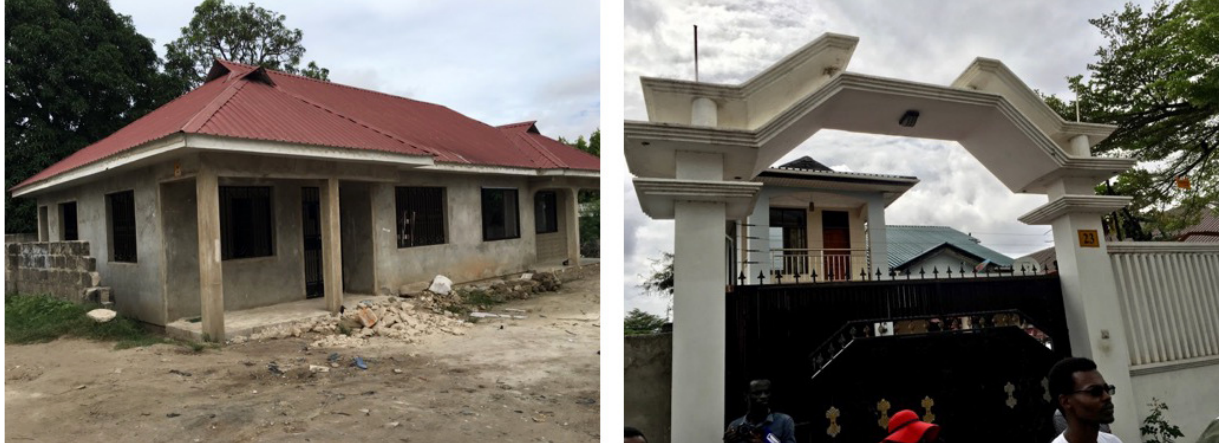
Figure 9. Renovation (left) and conversion of a Swahili house into higher‐income, single‐family homes (right).